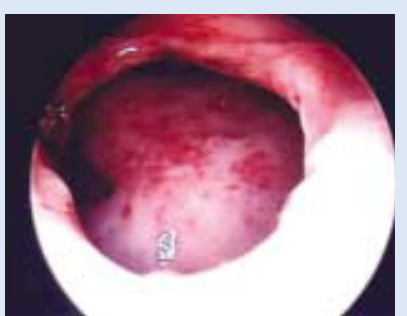
Fig. 4d. Nasal endoscopic view showing multiple nasal telangiectasias seen through a septal perfo- ration that has resulted from repeated surgical procedures for intractable